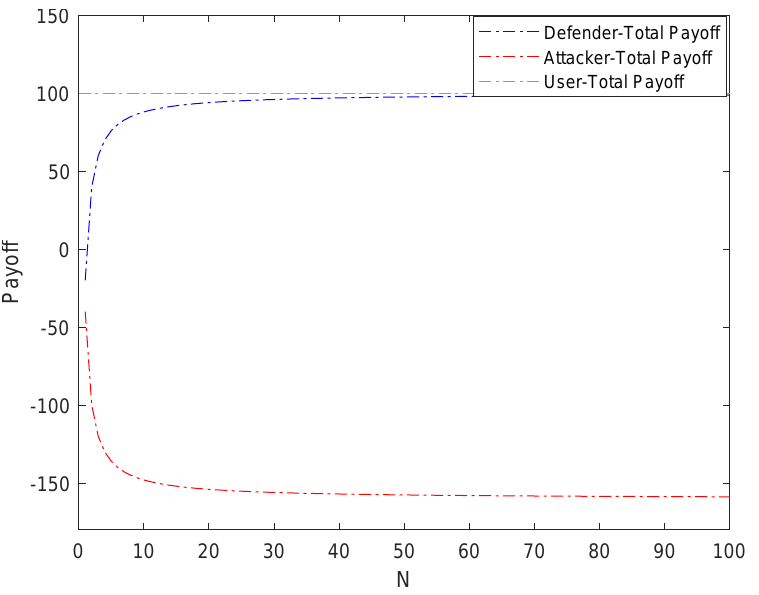
Figure 10. The three-party total revenue